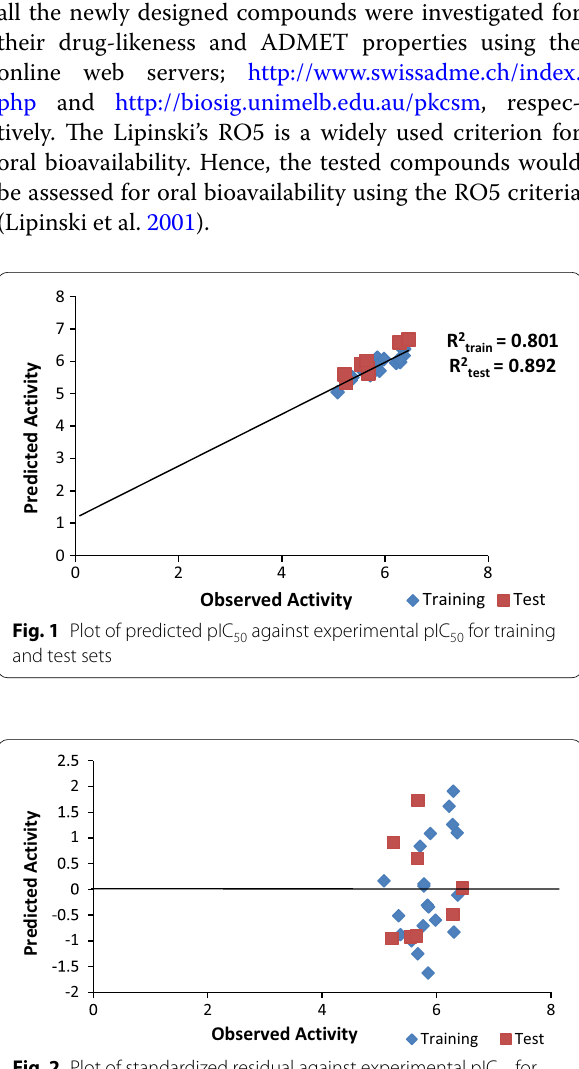
Fig. 2 Plot of standardized residual against experimental pIC 50 for training and test